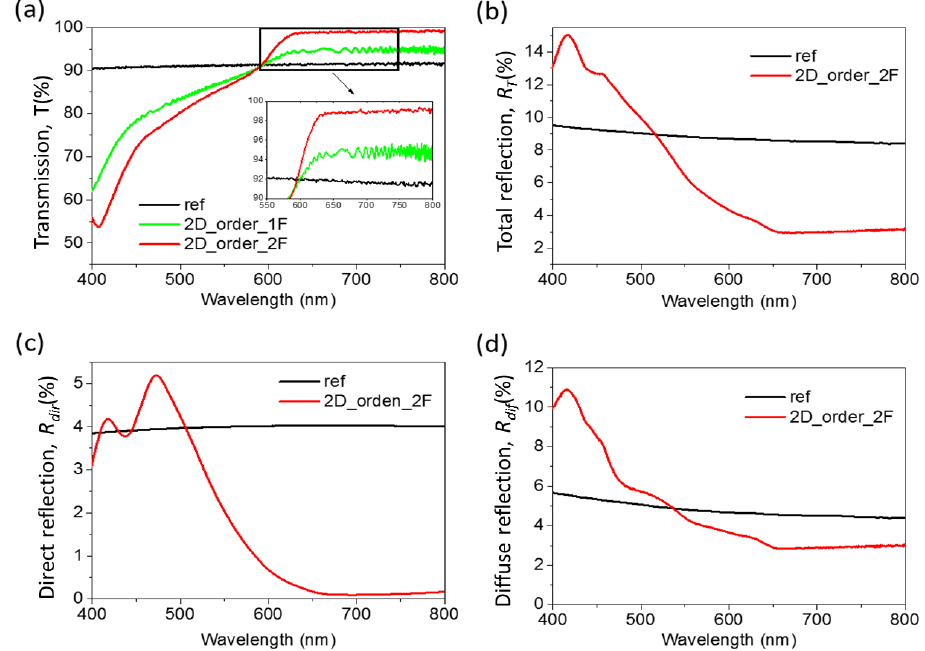
Figure 7. Optical measurements of ordered 2D nanostructures. ( a ) Transmission spectra ( T ) for glasses with nanostructures on a single side and on two sides. ( b ) Total reflection spectra ( R T ) for glasses with nanostructures on two sides. ( c ) Direct reflection ( R dir ) for glasses with nanostructures on two sides. ( d ) Diffuse reflection ( R dif ) for glasses with nanostructures on two sides.